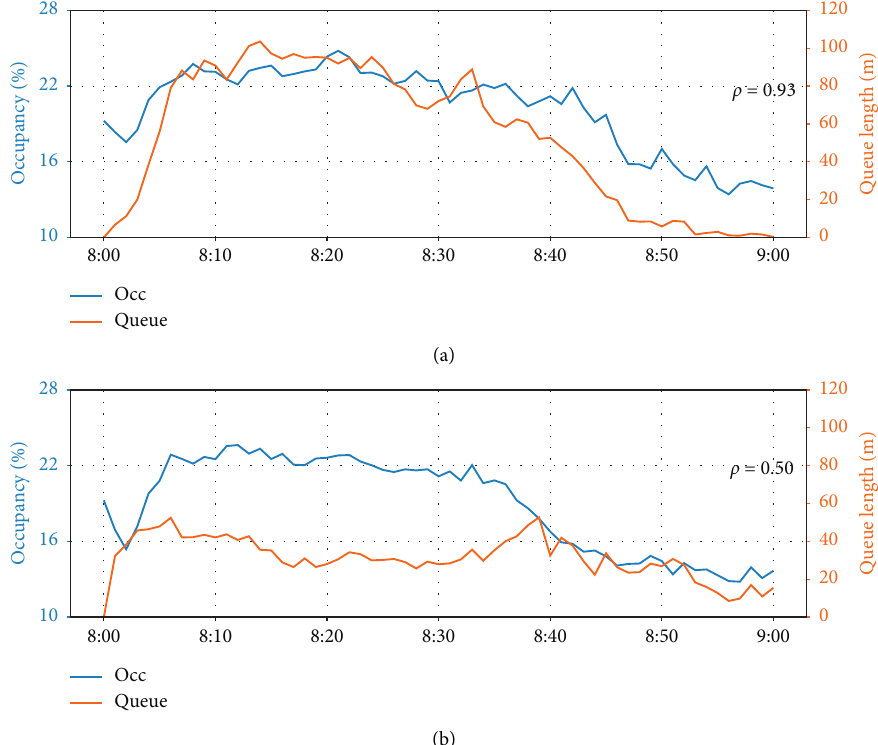
Figure 13: Queue length and occupancy for (a) PI-ALINEA and (b)